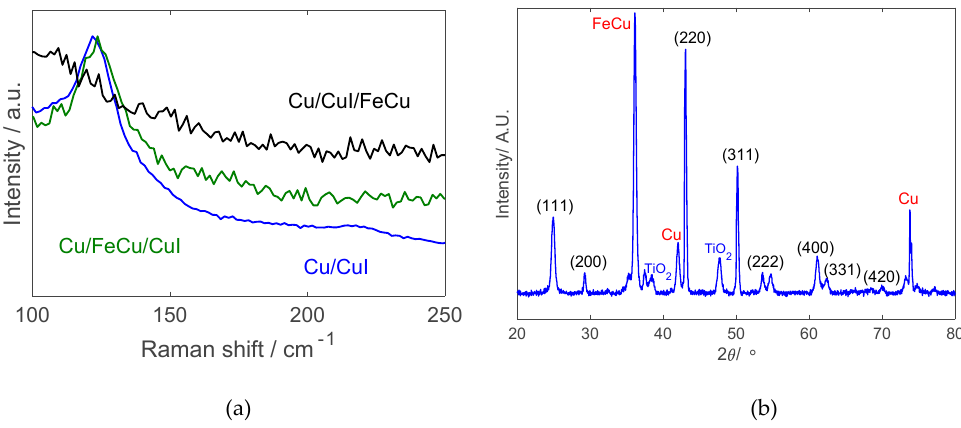
Figure 6. ( a ) Raman spectroscopy for all electrode deposition permutations and ( b ) X-ray diffraction patterns featuring the Cu/CuI/Cu electrode (crystallographic planes are shown for CuI).